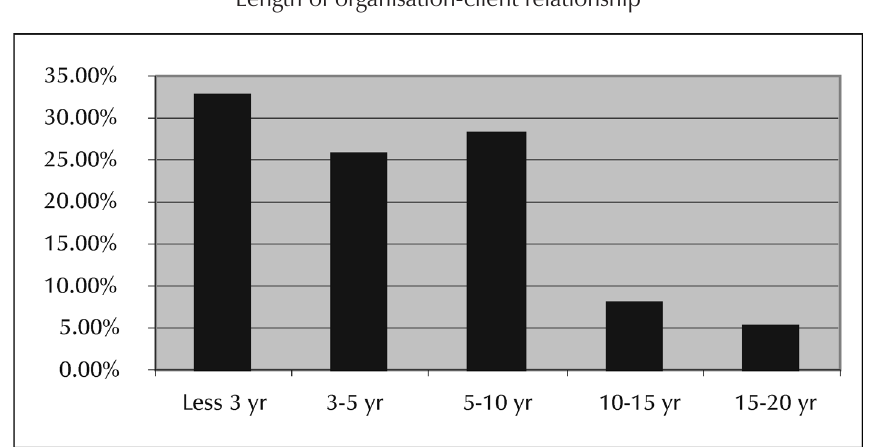
Length of organisation-client relationship